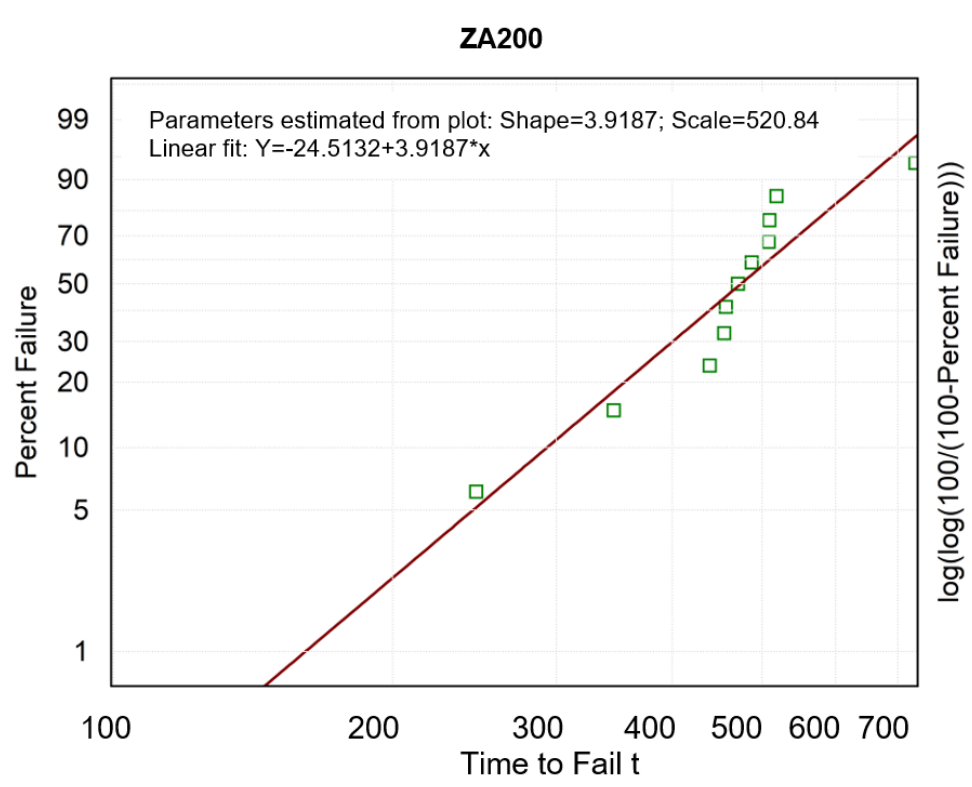
Figure 11. Weibull probability distribution for the wear of the ZA200 coating.